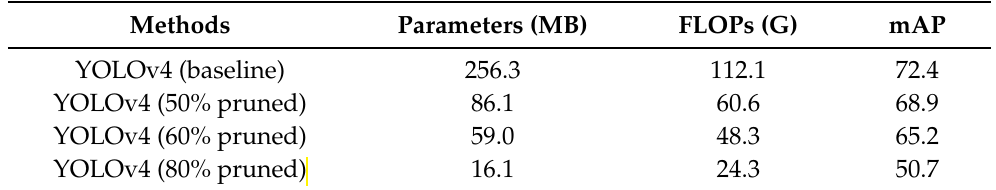
Table 4. Performance evaluation on the DOTA dataset.